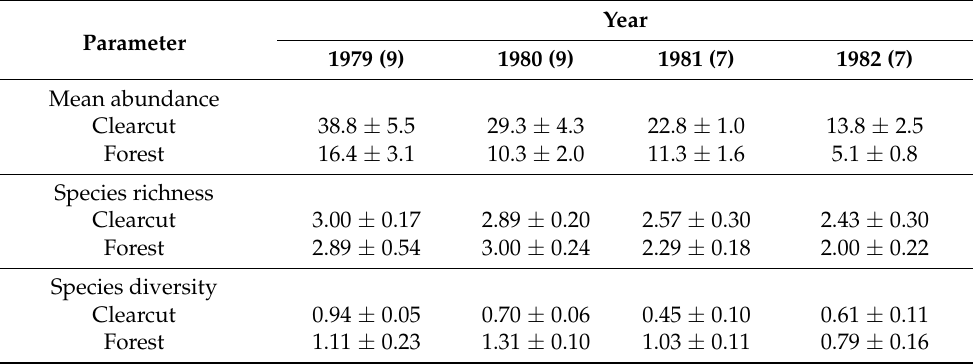
Table 3. Mean ( n = 1 replicate site) ± SE abundance, species richness, and species diversity per trapping period for forest-floor small mammals in forest and clearcut sites during Period 1 (1979 to 1982) for the CC-FOR study in southern BC, Canada. Number of trapping periods each year in